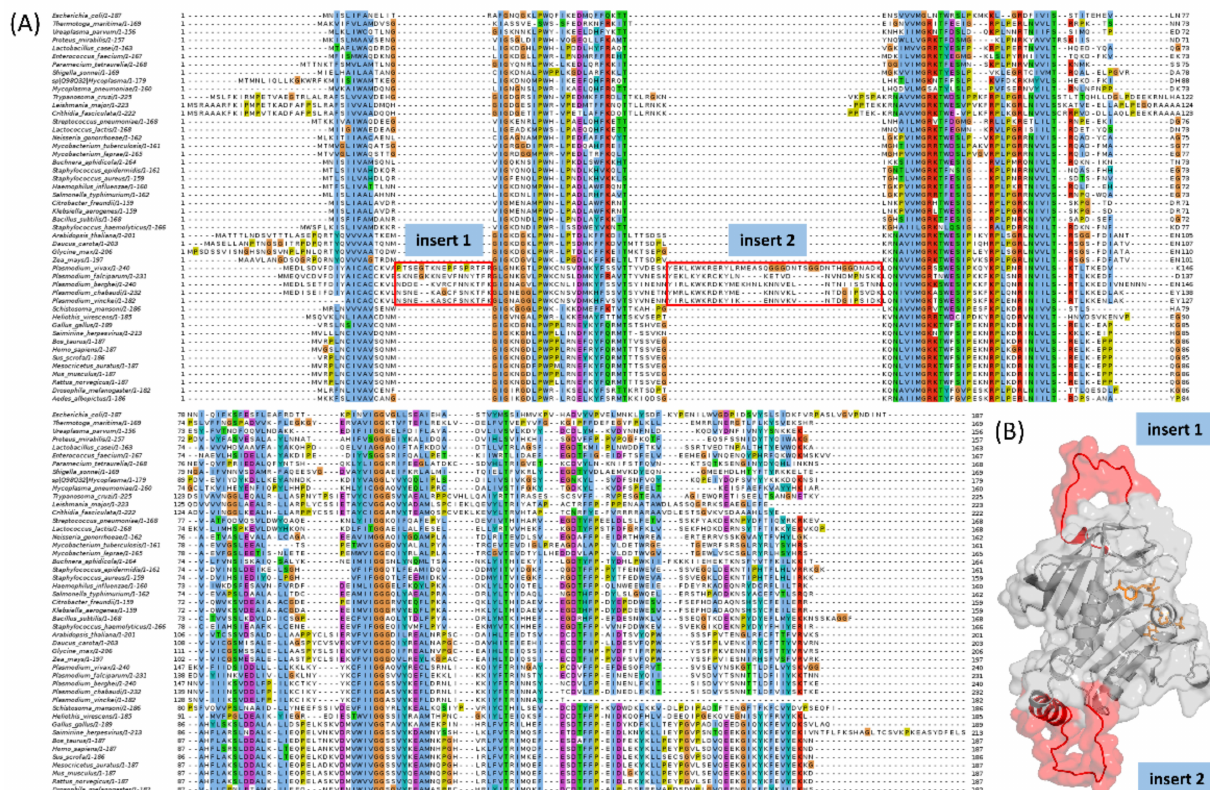
Figure 2. ( A ) Multiple sequence alignment highlighting two Plasmodium specific inserts (insert 1 and insert 2) in all of the Plasmodium species. ( B ) Structural mapping of the Plasmodium specific P. falciparum inserts to the modelled 3D structure of the